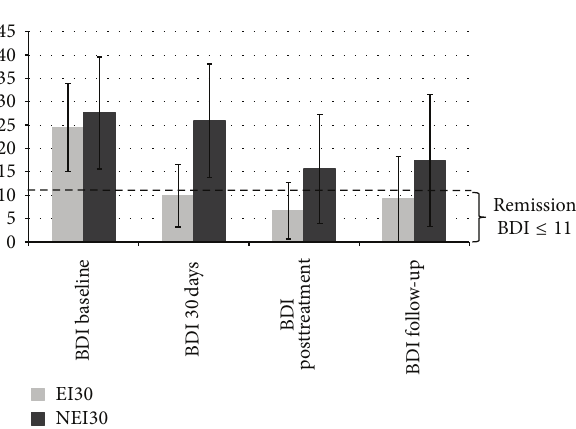
Figure 2: BDI scores overtime by study groups EI30 and NEI30.